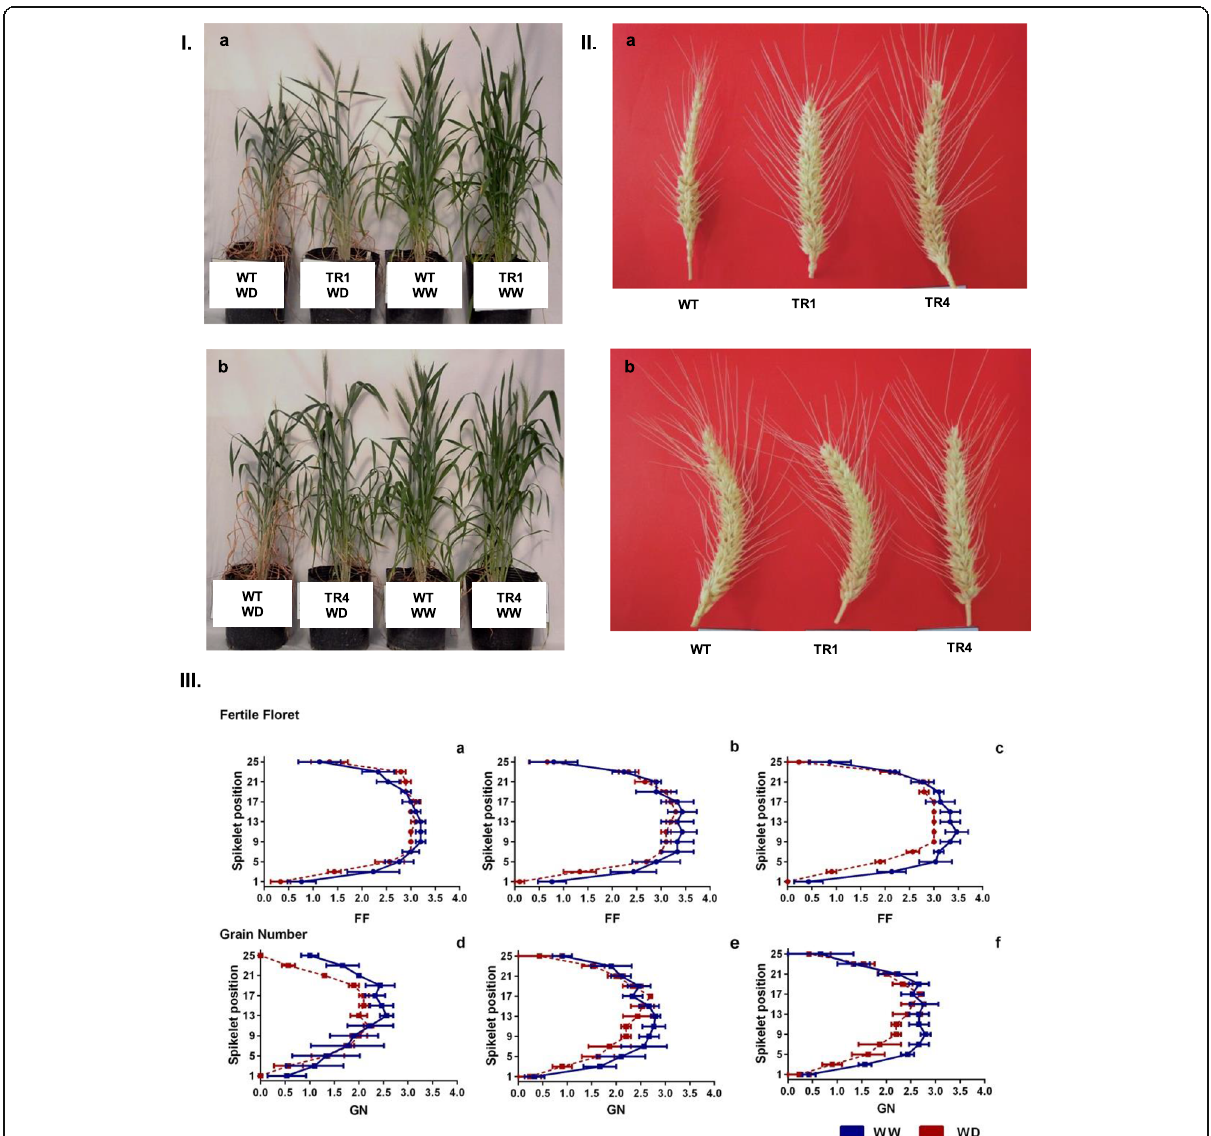
Fig. 5 Phenotyping transgenic plants under drought condition in EXP 2 and EXP 3. I Plants of the three genotypes under the two water treatments in EXP2. (a) WT vs. TR1 under water deficit (WD) and well-watered (WW) conditions; (b) WT vs. TR4 under WD and WW. II Main spike from the genotypes WT, TR1, and TR4 under different treatments in EXP2. (a) WD condition and (b) WW condition. III Profile of fertile florets and grain number per spikelet along with the spike (0 corresponds to the basal spikelet) in EXP3 for each genotype (WT, TR1, and TR4) under WD and WW conditions. (a – d) WT; (b – e) TR1; (c – f) TR4. The dotted lines correspond to WD and the line continues to WW conditions. Mean ± S.D., n = 15 for each data